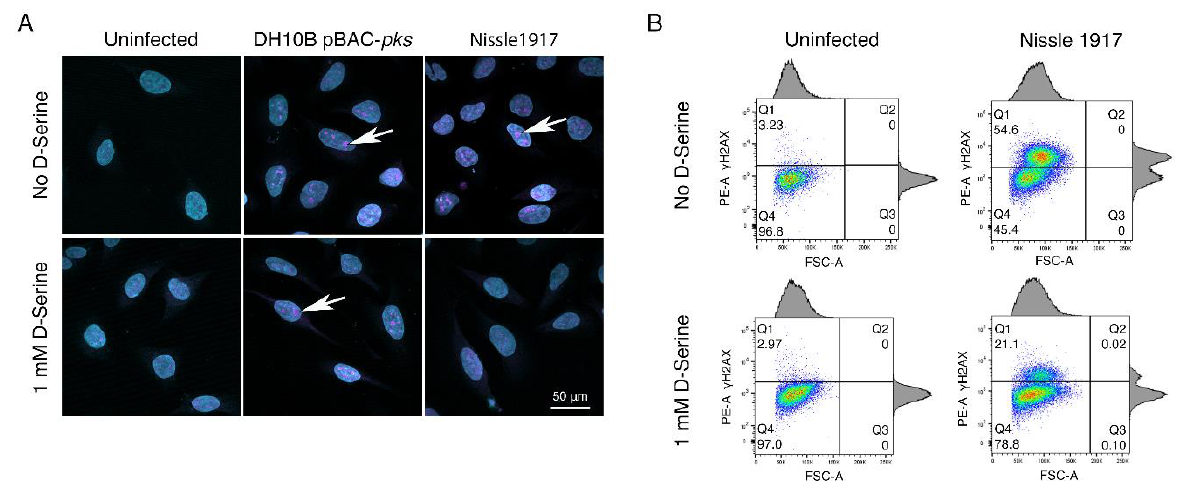
FIGURE 4: D-Serine reduces nuclear foci observed in HeLa cells. HeLa cells were infected for 4 h with E. coli Nissle 1917 or DH10B hosting BAC- pks (MOI = 400). Infections were performed with and without the addition of 1 mM D-Serine to the growth media. At 8 h post infection, cells were washed, fixed, and stained with anti- γ -H2AX antibody. ( A ) Cells were examined by confocal microscopy for DNA in cyan and phosphorylated histone H2AX protein in magenta. Images of uninfected, and pks + infected cells are shown, scale bar = 50 μm. ( B ) Intracellu- lar levels of phosphorylated histone H2AX were measured by flow cytometry 8 h after infection. Dot plots reveal the percentage of viable cells fluorescing in the γ -H2AX channel, 100k events were analysed for each